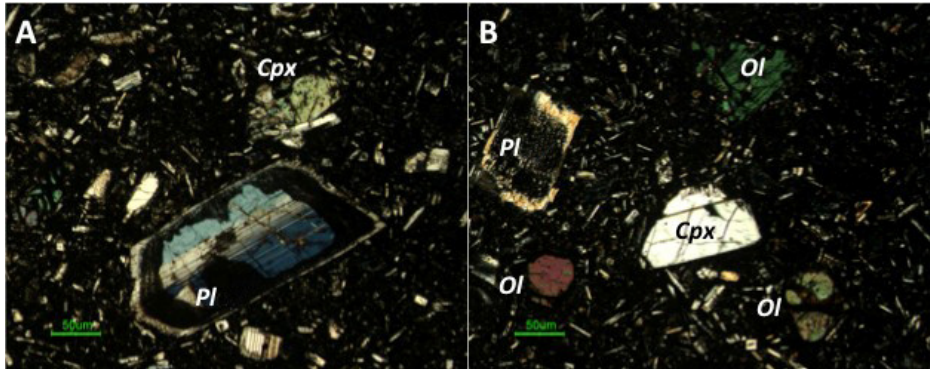
Figure 4. Petrographic features of porphyritic high-Nb basalts from the Utila Volcanic Center (northern Honduras). ( A ) clinopyroxene-plagioclase-phyric variety, ( B ) olivine-pyroxene-plagioclase-phyric variety. In both cases, groundmass is composed of plagicoclase microliths and partially altered glass. Ol—olivine, Cpx—clinopyroxene (Ti-augite), Pl—plagioclase. Detailed petrographic descriptions are available in [131].